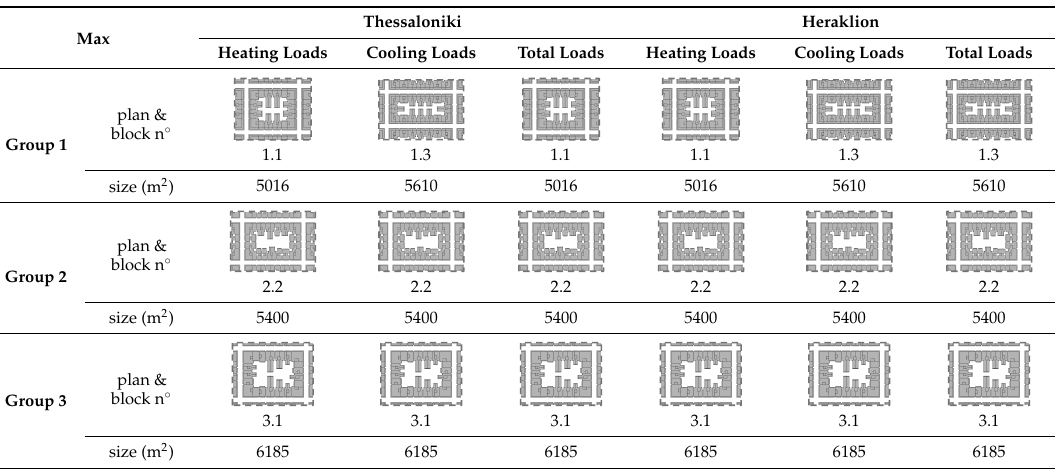
Table 7. Urban blocks presenting the minimum values for heating cooling and total load demand in each group for the two examined cities.